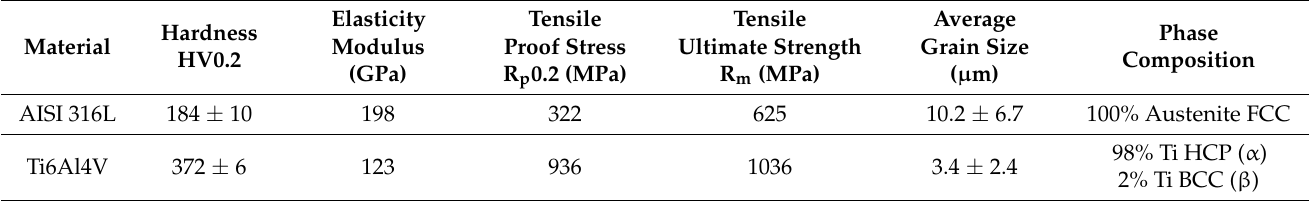
Table 1. Mechanical Properties of Experimental Materials.